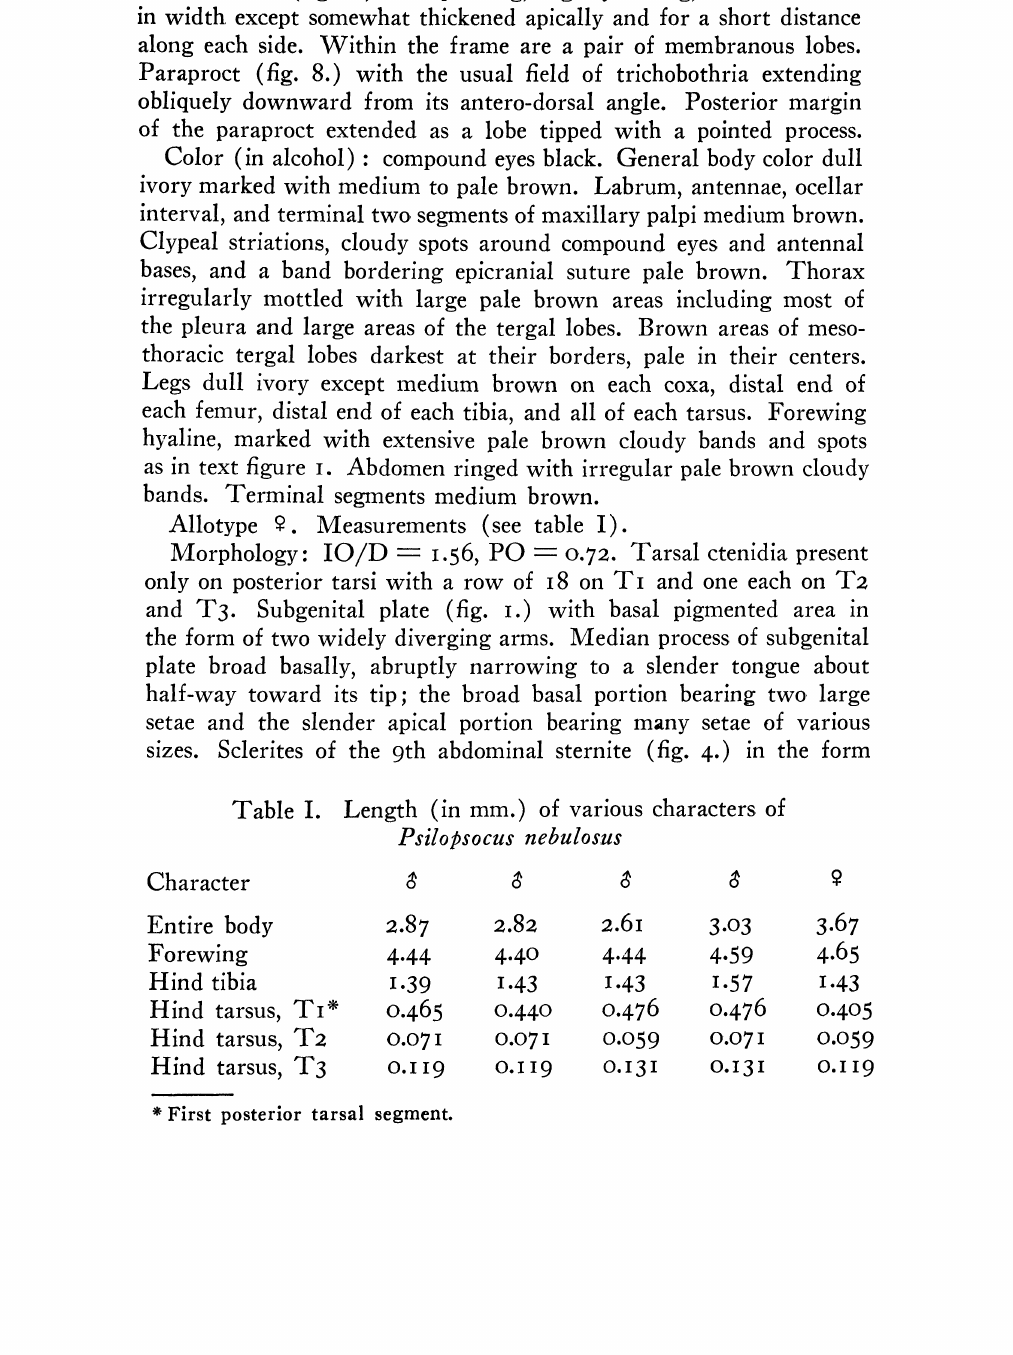
o various characters